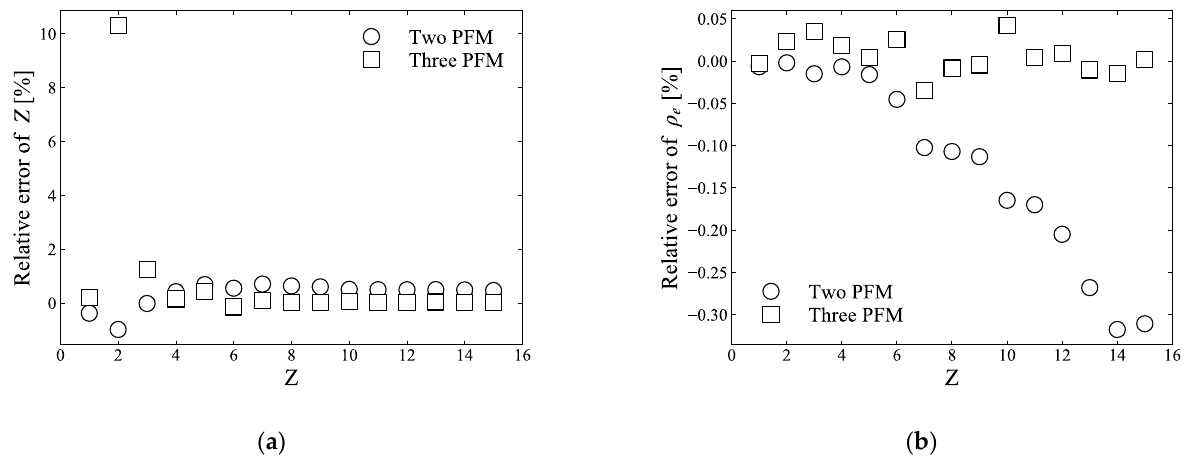
Figure 3. ( a ) shows the relative errors of the atomic number calculated via two-PFM using Equation (8) and three-PFM using Equation (12), respectively, compared to the theoretical values, and ( b ) shows the relative errors of the electron density calculated via two-PFM using Equation (9) and three-PFM using Equation (13), respectively, compared to the theoretical values.